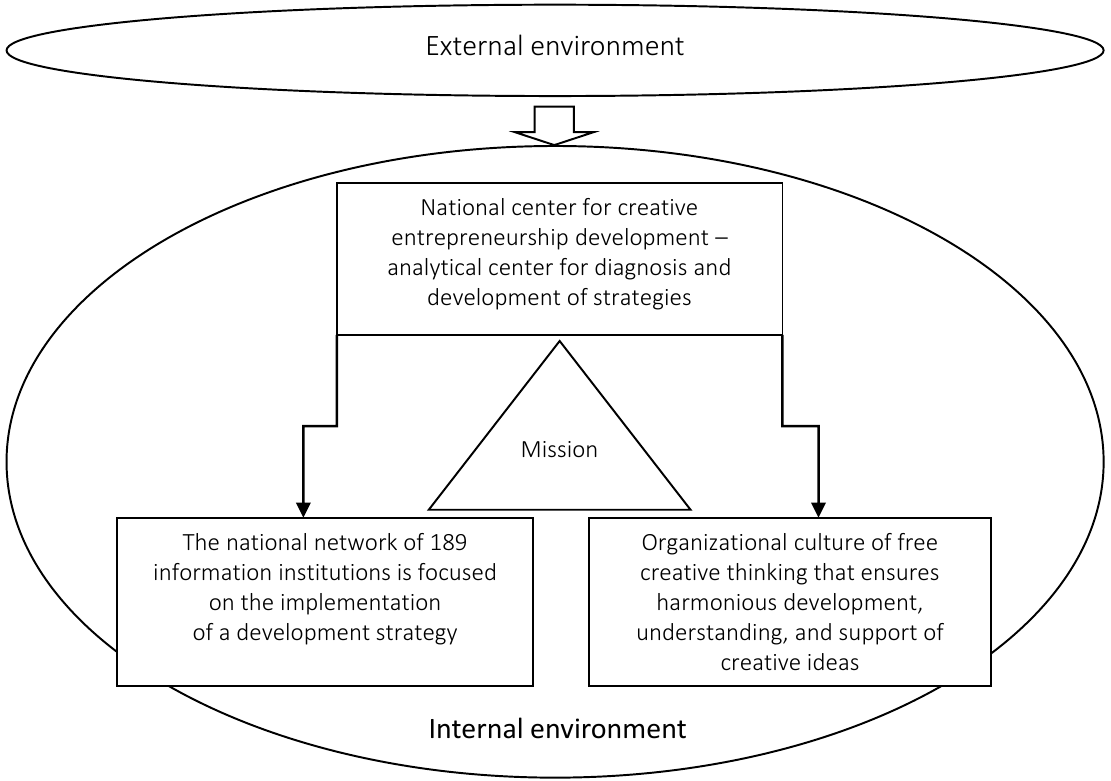
Figure 1. Strategic management of creative industries on the example of university libraries of